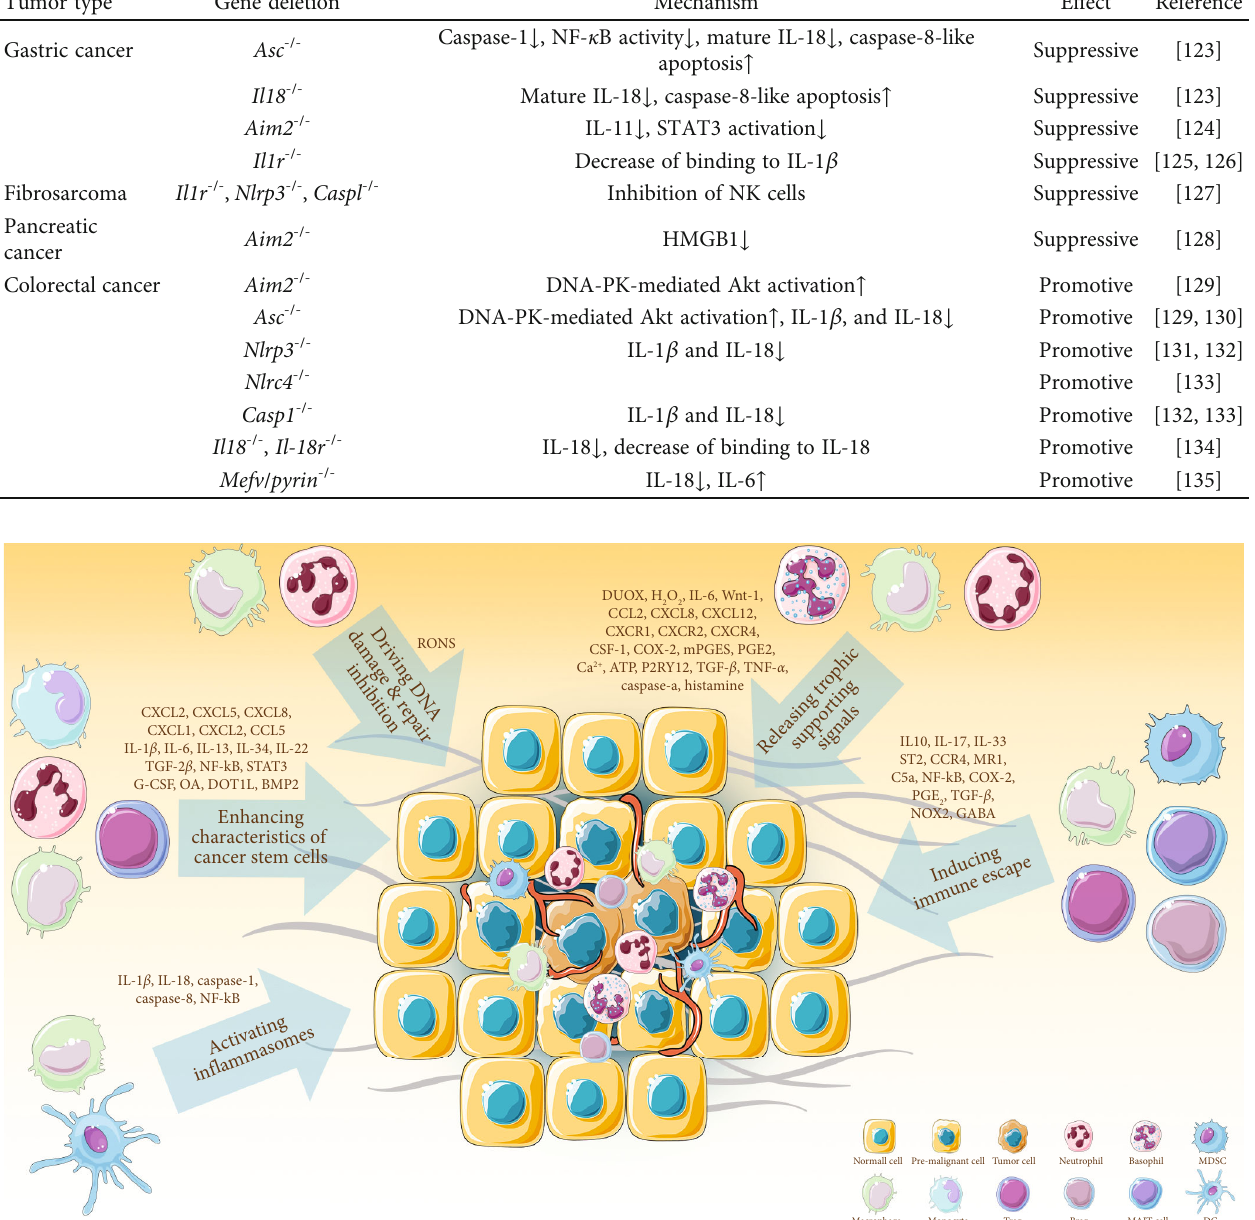
Table 1: The e ff ects of in fl ammasome activation in mouse tumorigenesis